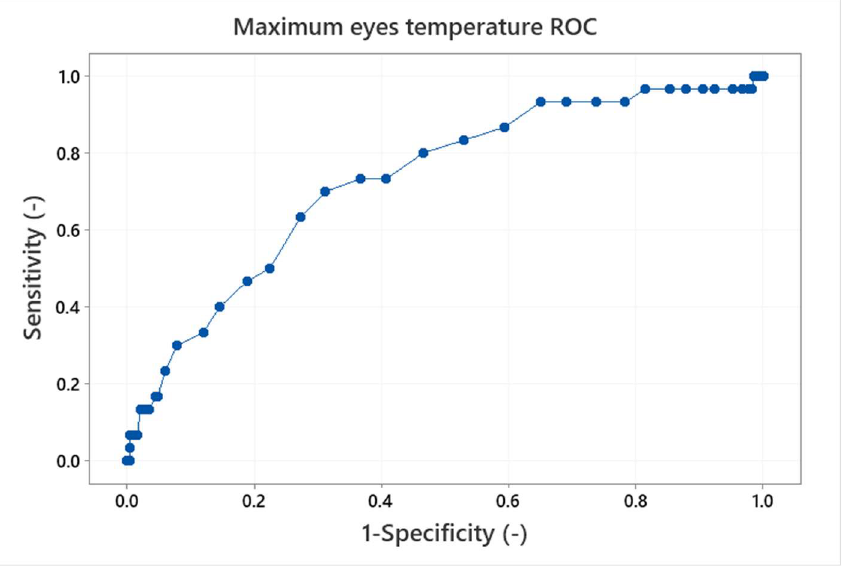
Figure 16. Receiver operation curve (ROC) for the maximum eyes temperature and the APT threshold 36.5 °C. The area under curve is 0.72.